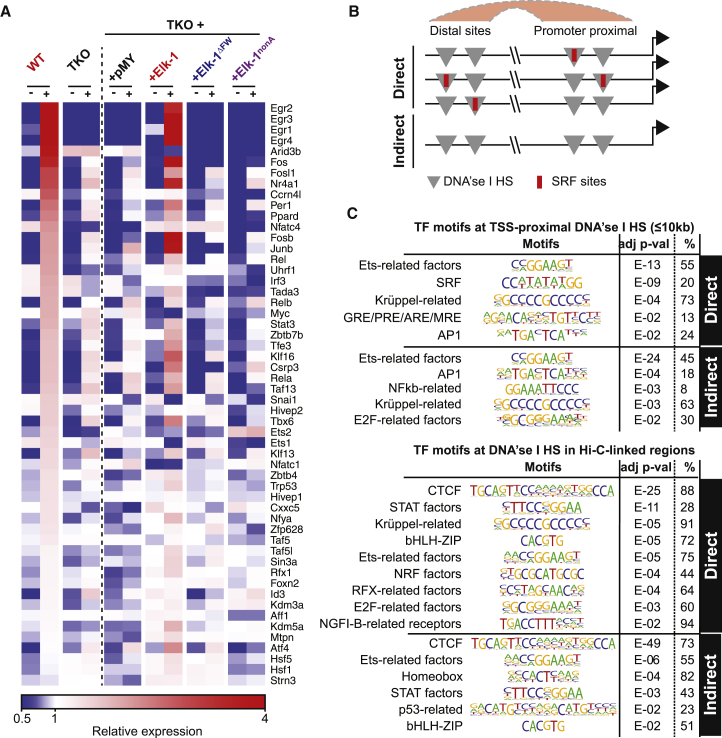
Indirect and Direct TCF-Dependent Target Genes Are Linked by Transcriptional Regulation(A) Heatmap representation of TPA-induced transcription of 54 transcription factor genes from the Direct TCF target gene set, ranked by magnitude of the TPA-induced changes in wild-type MEFs.(B) Potential relationships between DNase I HS (gray) and SRF binding sites (red) at TSS-proximal or remote regulatory sites of Direct and Indirect TCF target genes, with Hi-C linkages indicated by the crescent.(C) TF motifs occurring in putative regulatory regions (DNase I HS summit ± 100 bp) of Direct and Indirect TCF target genes. Motifs scoring as significantly enriched relative to their representation across all DNase I HS-associated sequences are shown together with their frequency. CTCF was recovered at all distal motifs, presumably reflecting its association with the insulator elements that define compartment boundaries.See also Table S6.